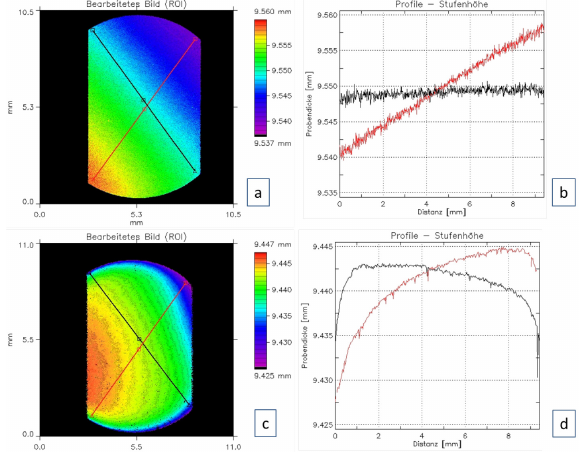
Fig. 5. Thickness of a carbon sample after lapping (top) and after polishing (bottom) 2D colour-coded (a and c) and in a graph along the profile lines (b and